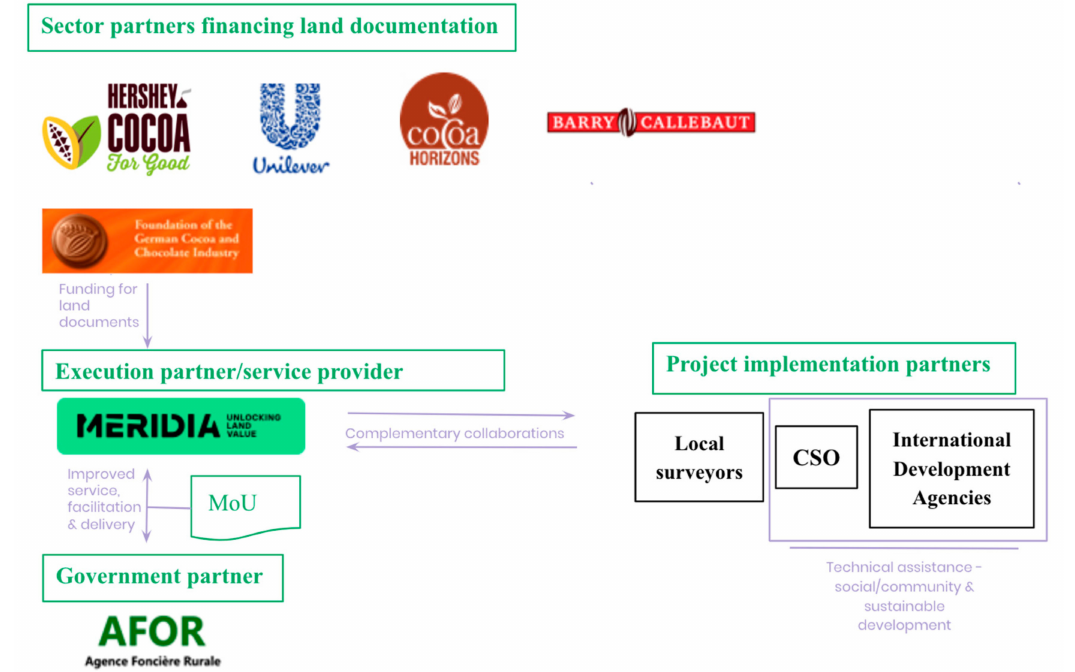
Figure 1. Partners in